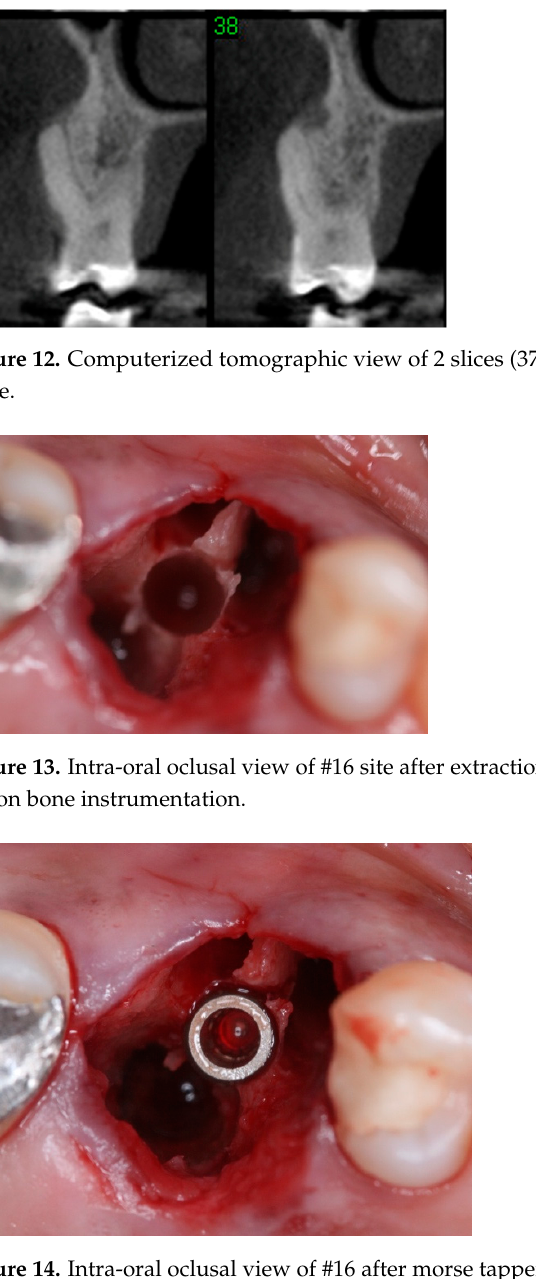
Figure 11. Intra-oral oclusal view of #16, indicated for extraction.